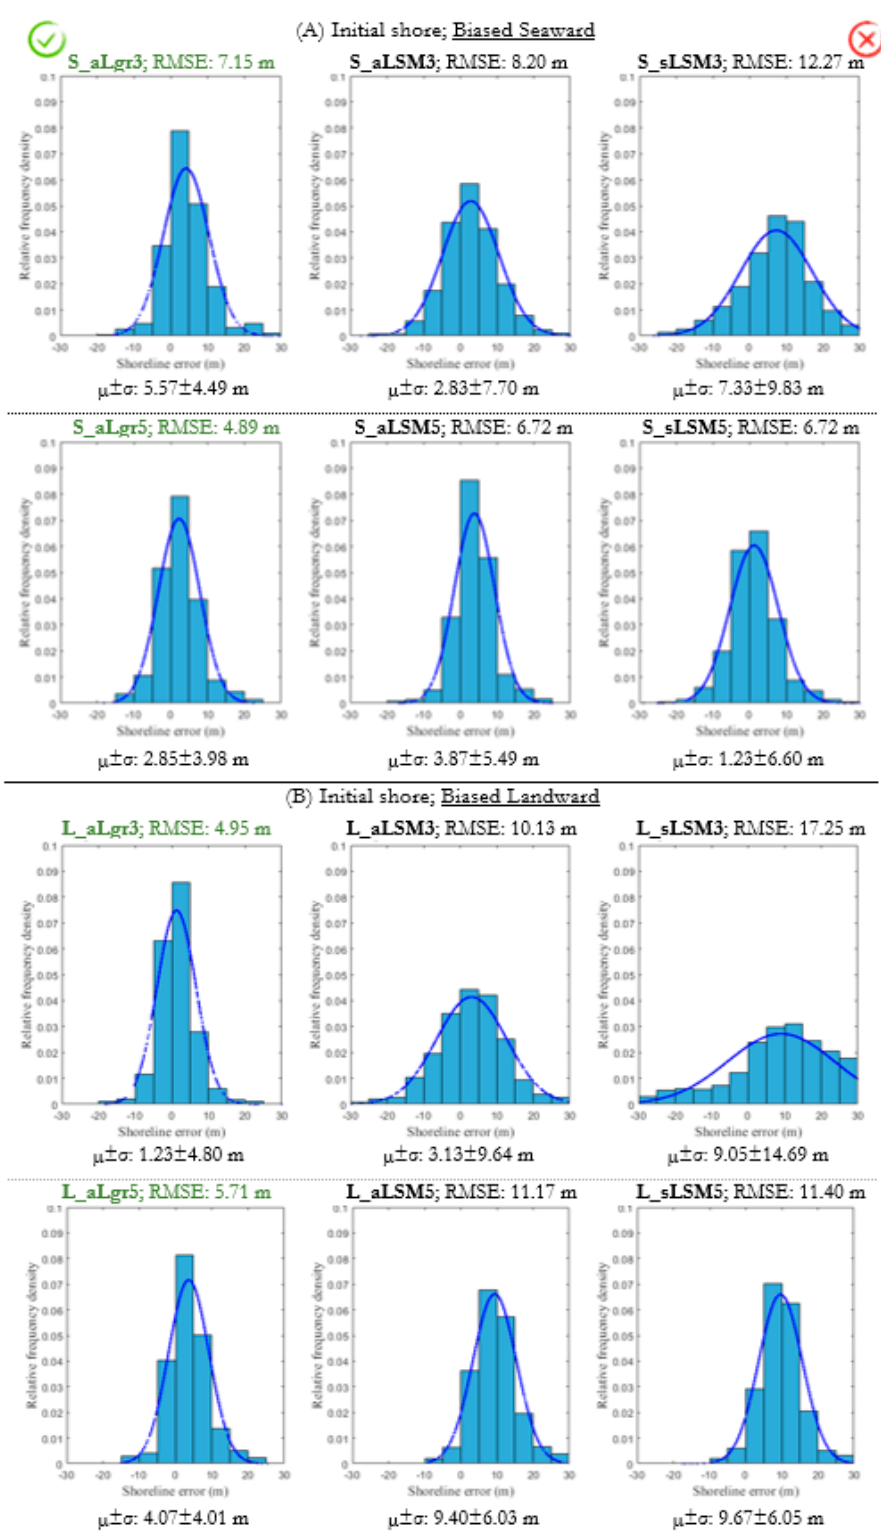
Figure 10. Histograms representing the density function of the sub-pixel shoreline errors in the beach area depending on the bias of the pixel-level shoreline—seaward ( A ) or landward ( B )—and the methodology used. A normal density function using the average ( µ ) and the standard deviation ( σ ) of the data is also considered by leaving underneath a total area of